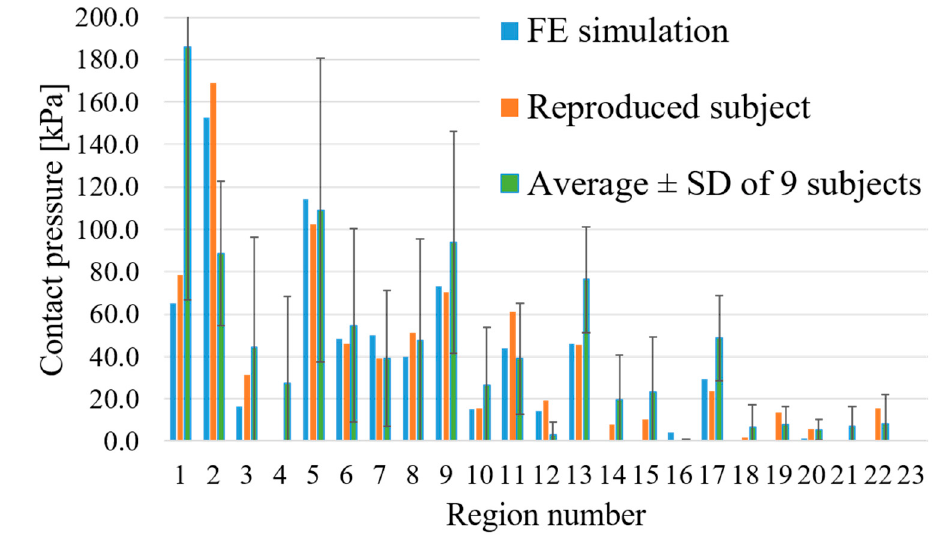
Figure 10. Comparison of the contact pressure value between the FE simulation result and experimental result. Contact pressure of reproduced subject and average ± SD of 9 male subjects were obtained from our previous study [6].